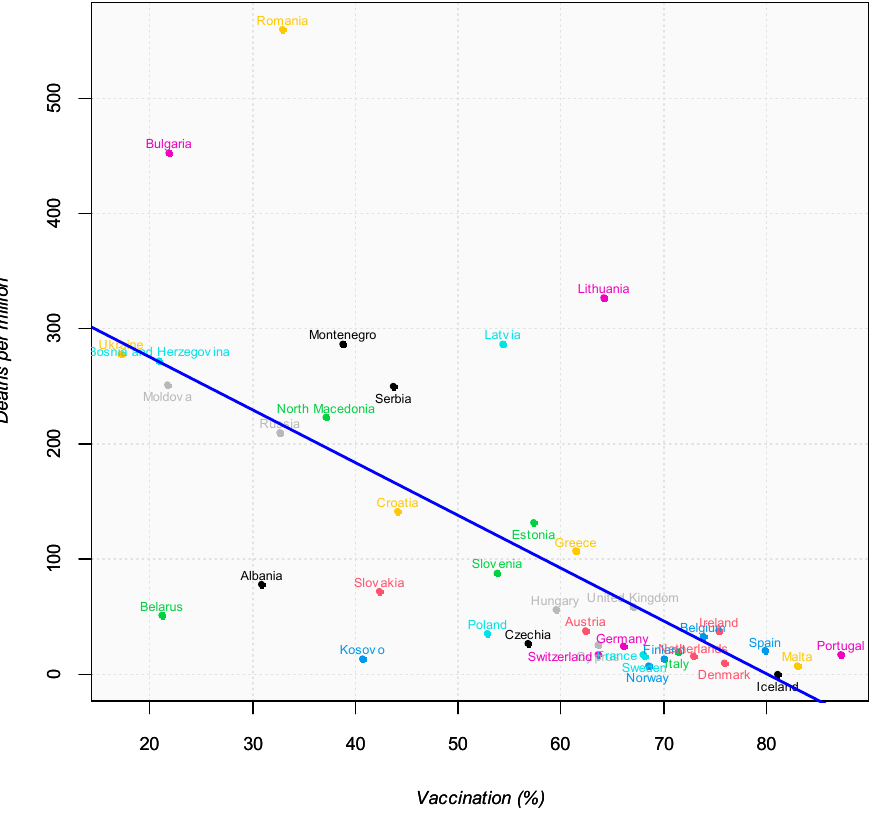
Figure 9. Vaccination coverage and deaths according to European Countries as of 31 October 2021.